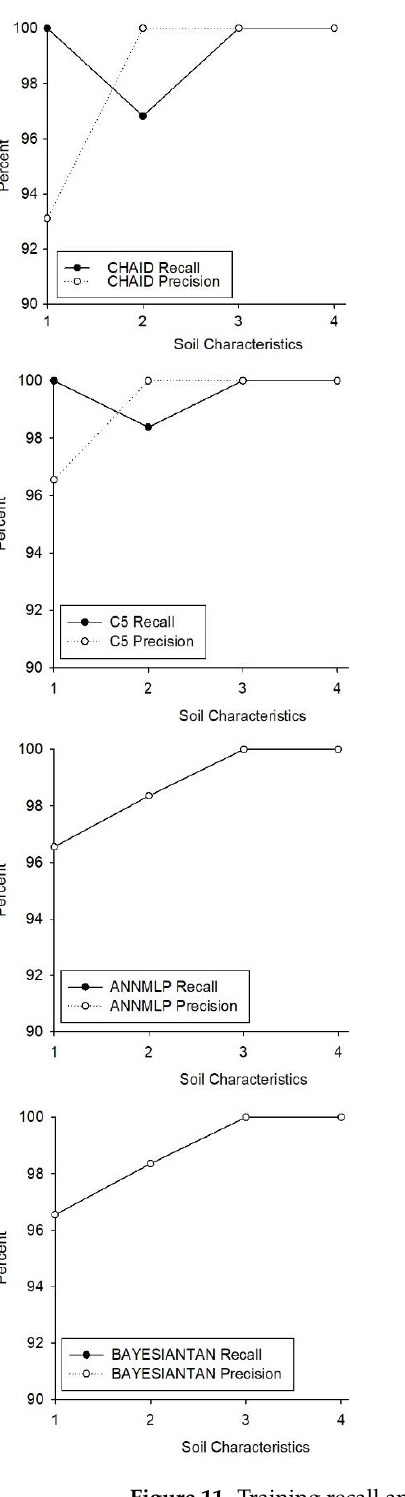
Figure 11. Training recall and precision of the models employed.